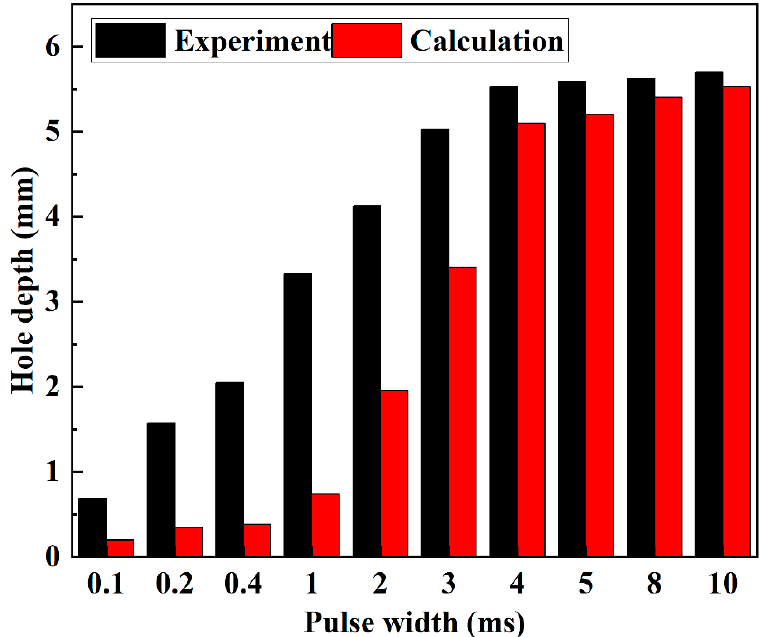
Figure 15. Experimental and calculated hole depth under different pulse width at the peak power of 500 W. of 500